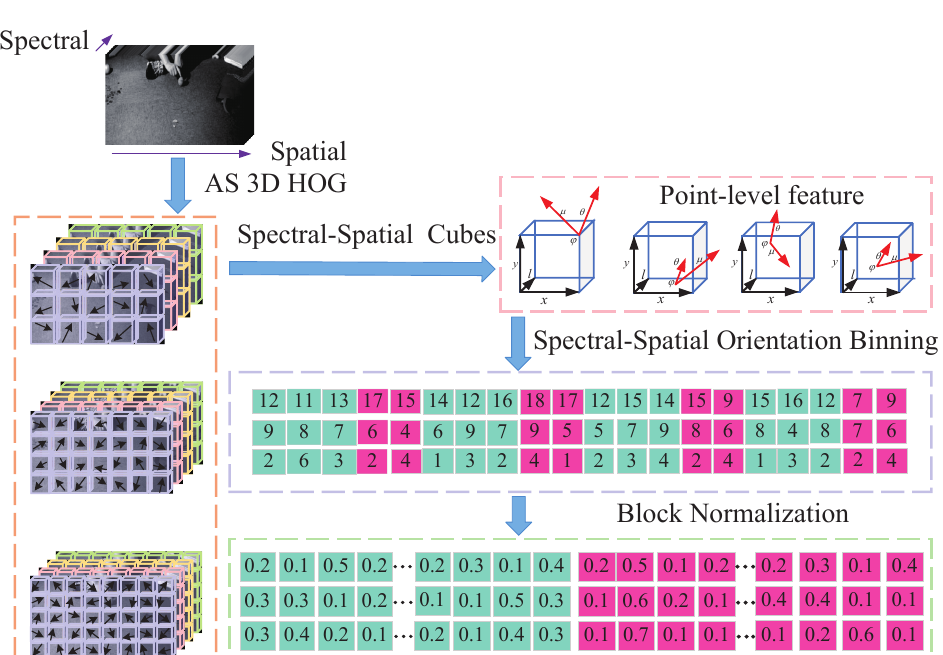
Figure 6. Schematic diagram of AS 3D HOG features. The original hyperspectral image is divided according to three different scales, HOG features are calculated separately in each cube, and each HOG feature is concatenated to obtain the final AS 3D HOG. The dark squares represent the results of spectral direction and the light squares represent the results of spatial